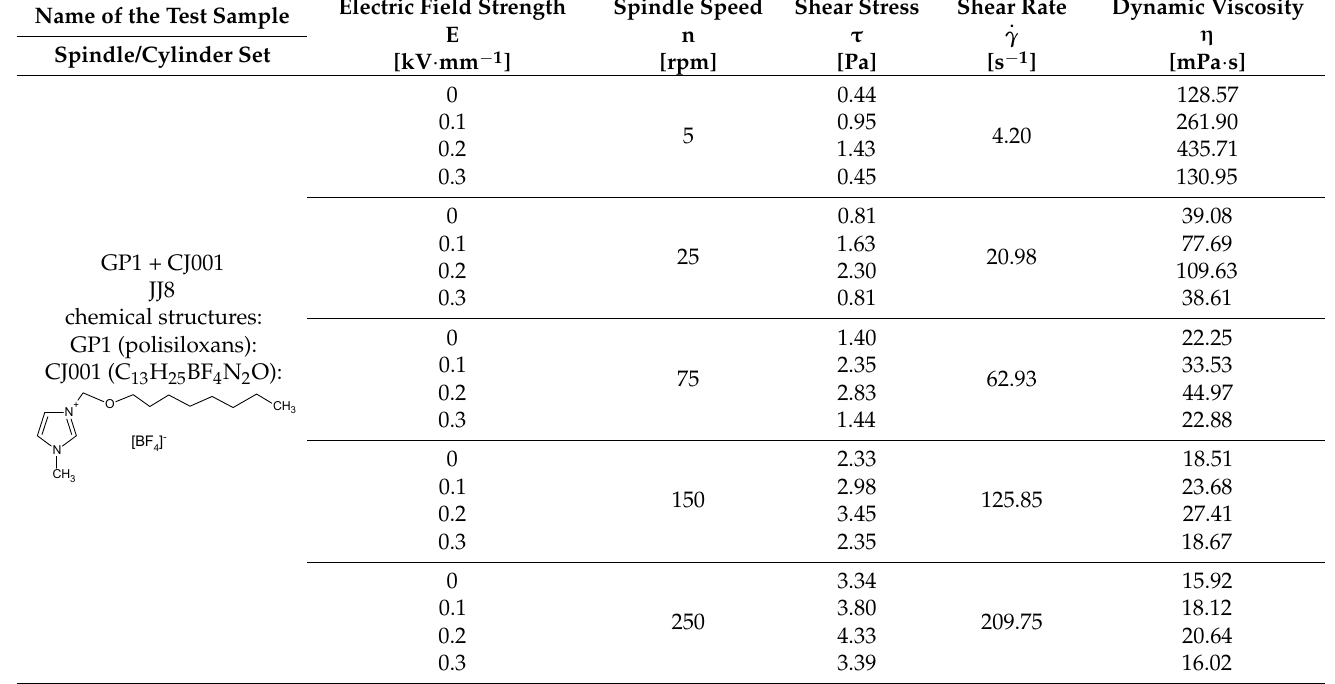
Table 3. Results of research on ER properties of GP1 + CJ001 mixture.